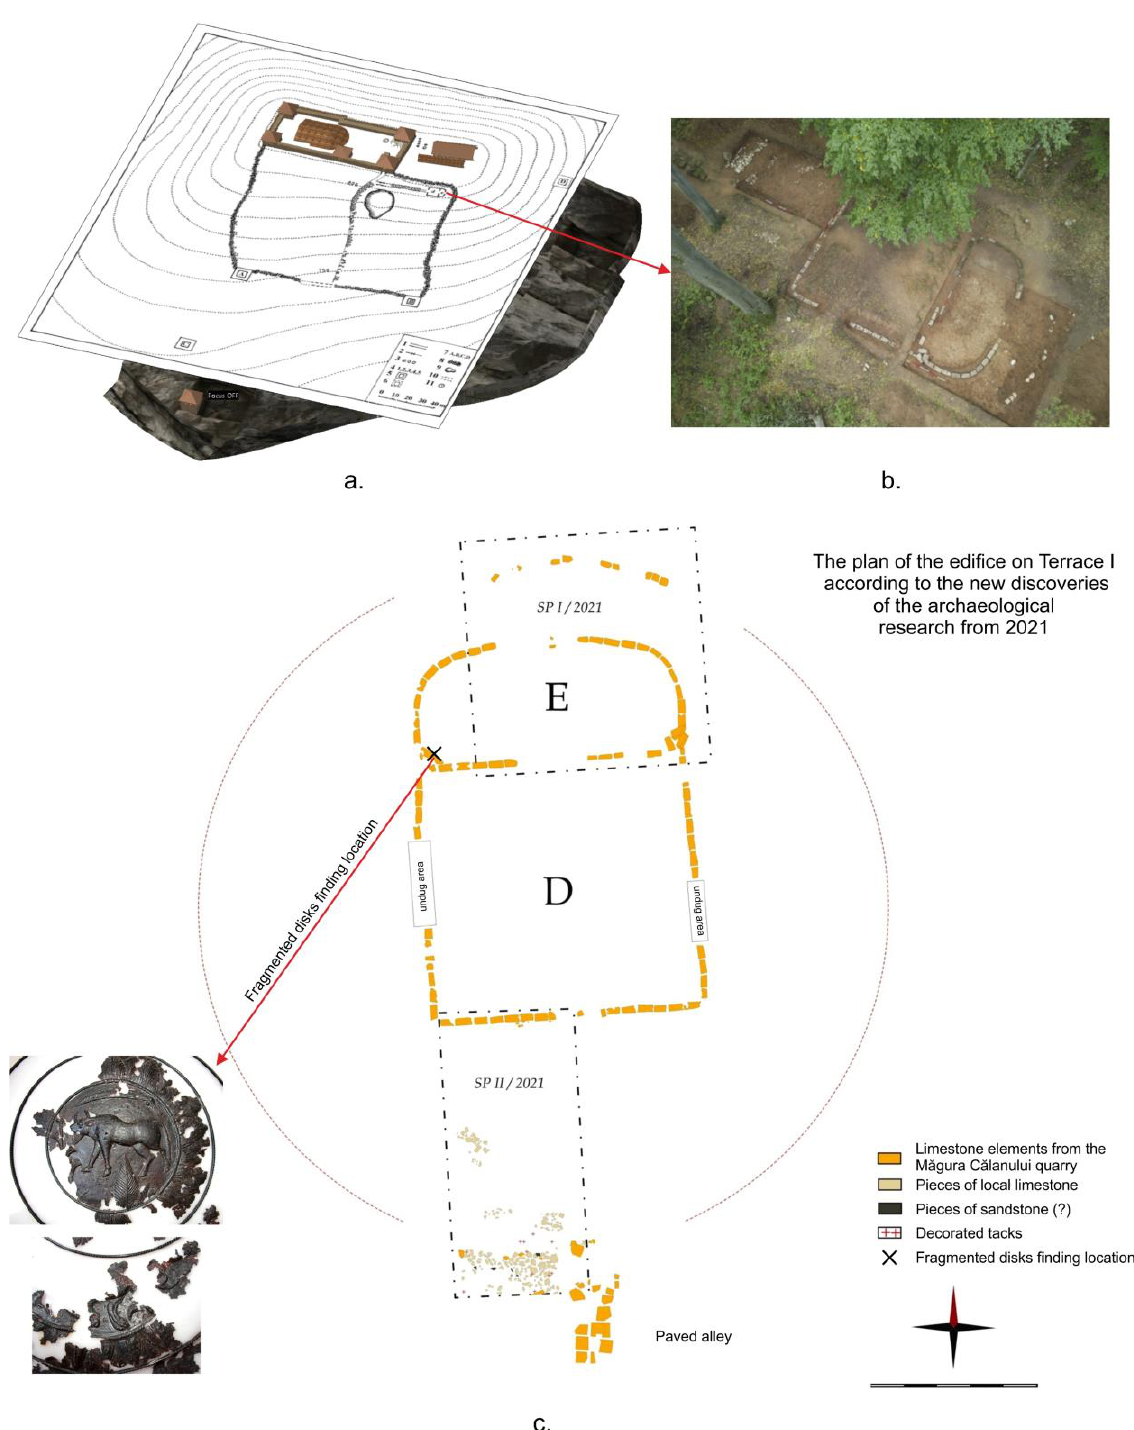
Figure 1. ( a ) Three-dimensional reconstruction of the Piatra Ros topographic map; ( b ) Overview of the building with limestone foundations on terrace I, photography taken by authors ( c ) . The plan of the edifice on terrace I, drawn by authors according to the 2021 archaeological